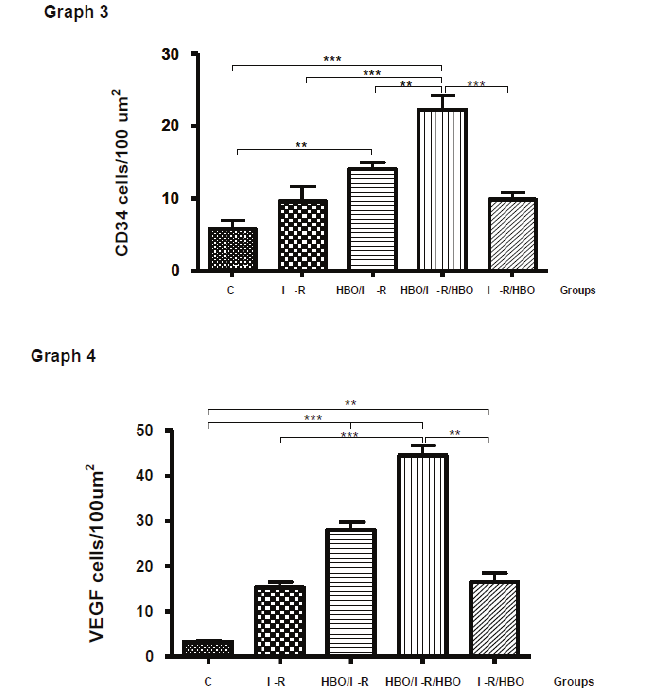
FIGURES 5 and 6 - Results from the CD34+ and VEGF determination in the experimental and Control groups. There are significant differences among the groups.